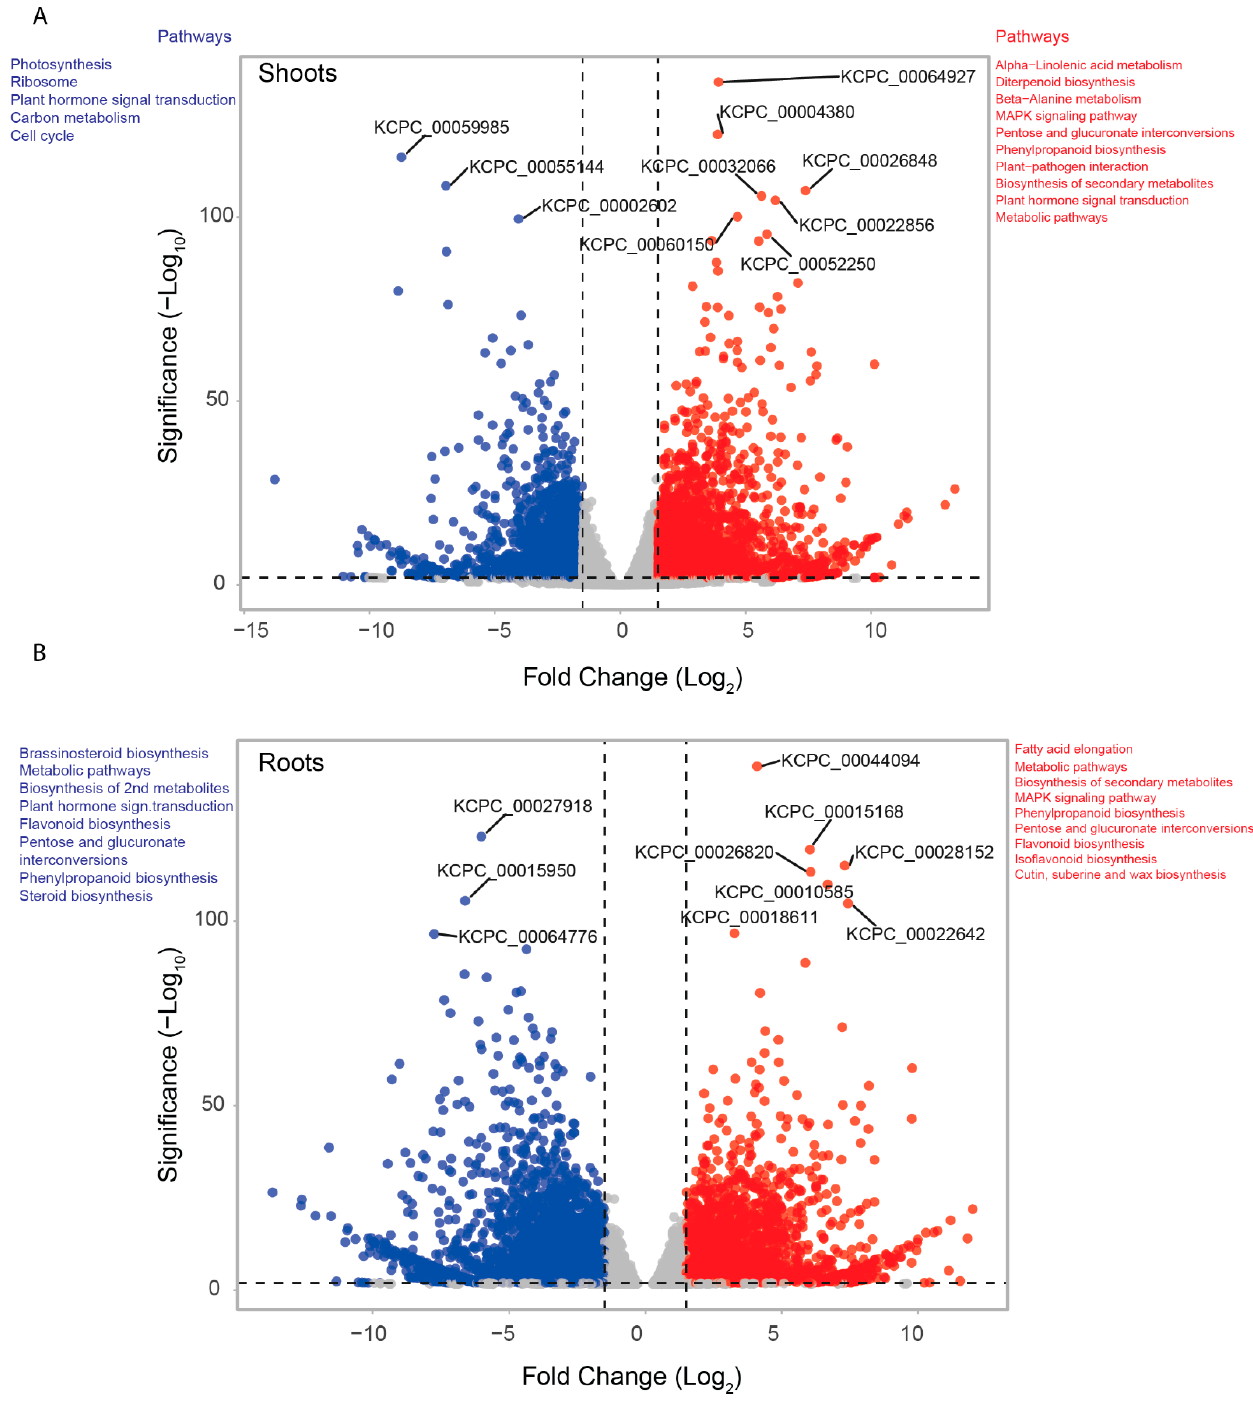
Figure 6. Differential gene expression in shoots and roots of P. cineraria under 250 Mm salt stress. ( A ) Volcano plot of shoots of up-regulated (red) and down-regulated (blue) at log 2 fold change in 2 and − log 10 significance. Gray dots represent neutral (relatively unchanged) genes. The names of the top up-regulated and down-regulated genes are indicated. Pathway enrichment analysis for the up-regulated (red) and down-regulated (blue) genes are depicted outside the volcano plot. ( B ) Volcano plot of roots of up-regulated (red) and down-regulated (blue) at log 2 fold change in 2 and − log 10 significance. Gray dots represent neutral (relatively unchanged) genes. Names of top up-regulated and down-regulated genes are indicated. Pathway enrichment analysis for the up-regulated (red) and down-regulated (blue) genes are depicted outside the volcano